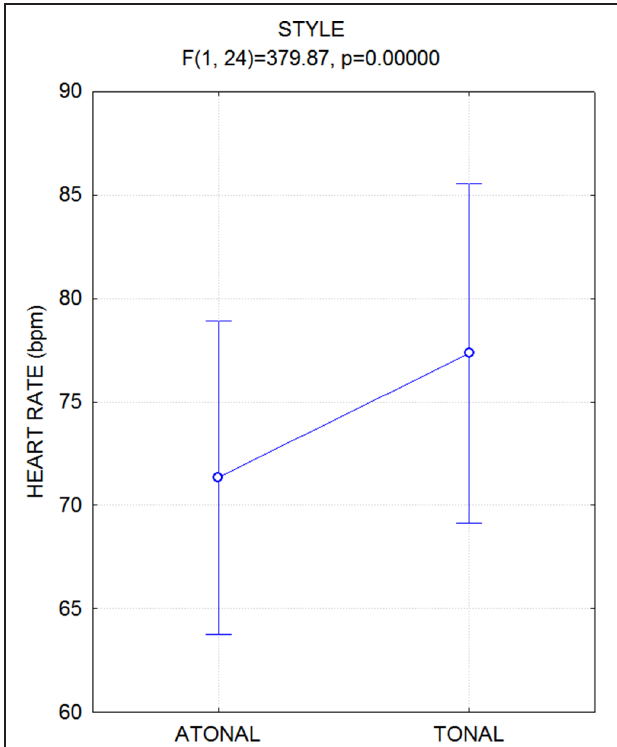
FIGURE 4 | Mean values of heart rate (BPM), along with standard errors, recorded while participants listened to atonal vs. tonal music